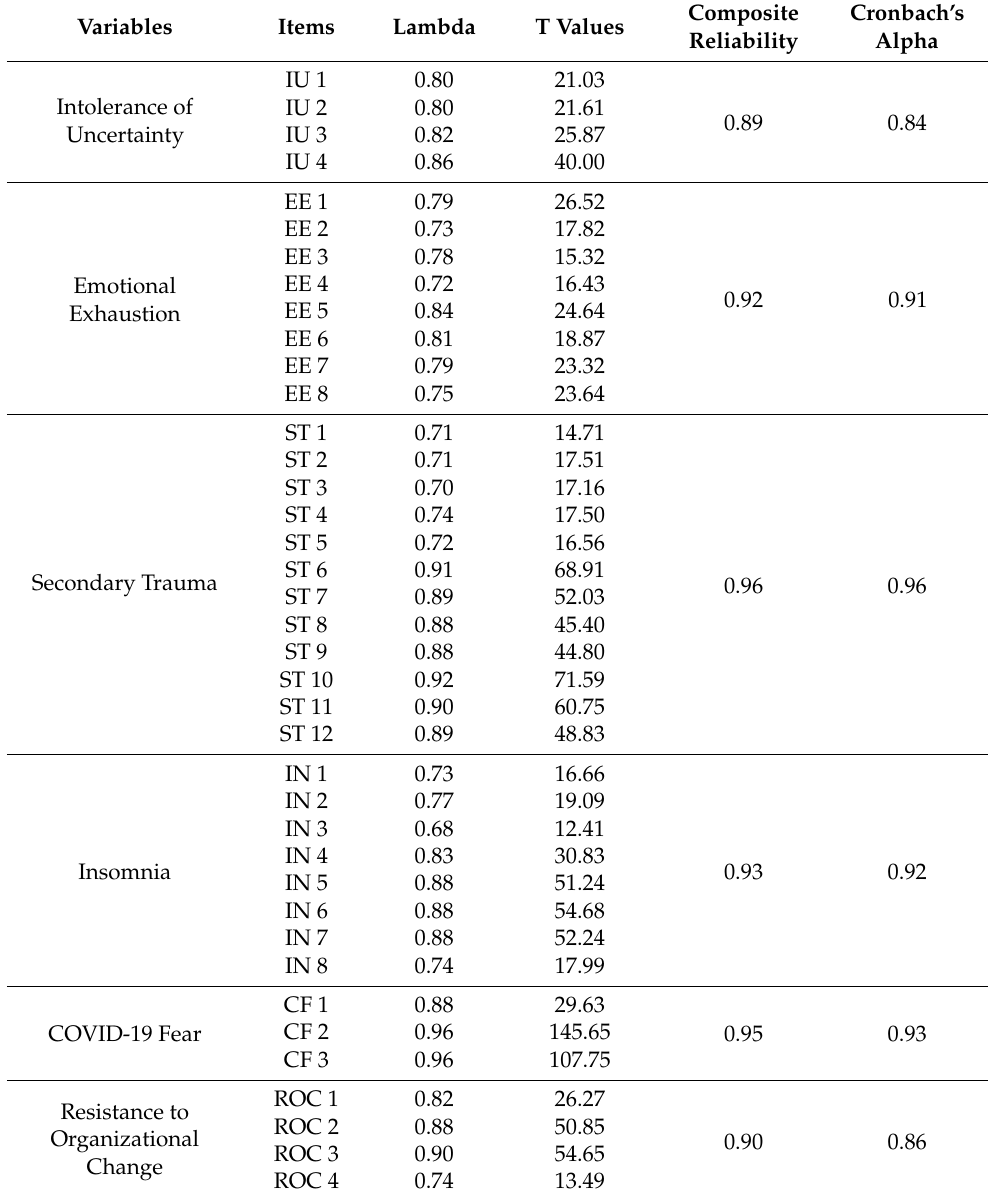
Table 2. Item loading and model